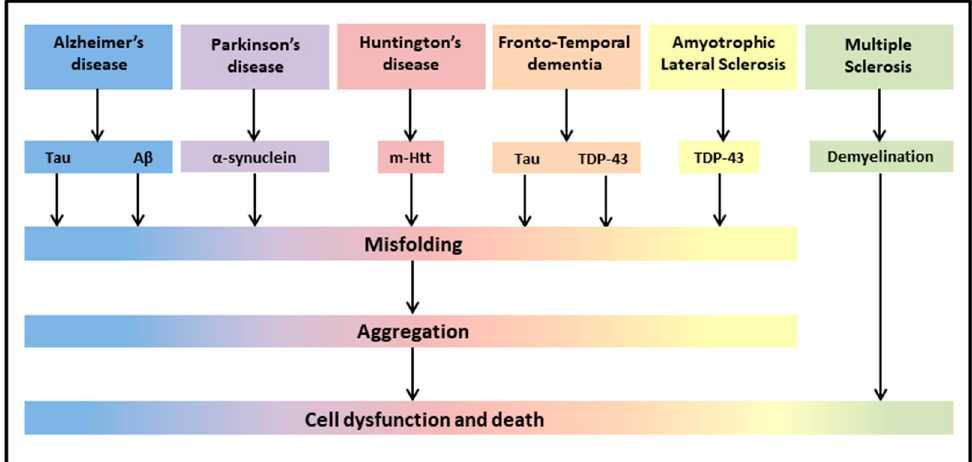
Figure 1. Neurodegenerative diseases share common pathological hallmarks leading to cell dysfunction and death.